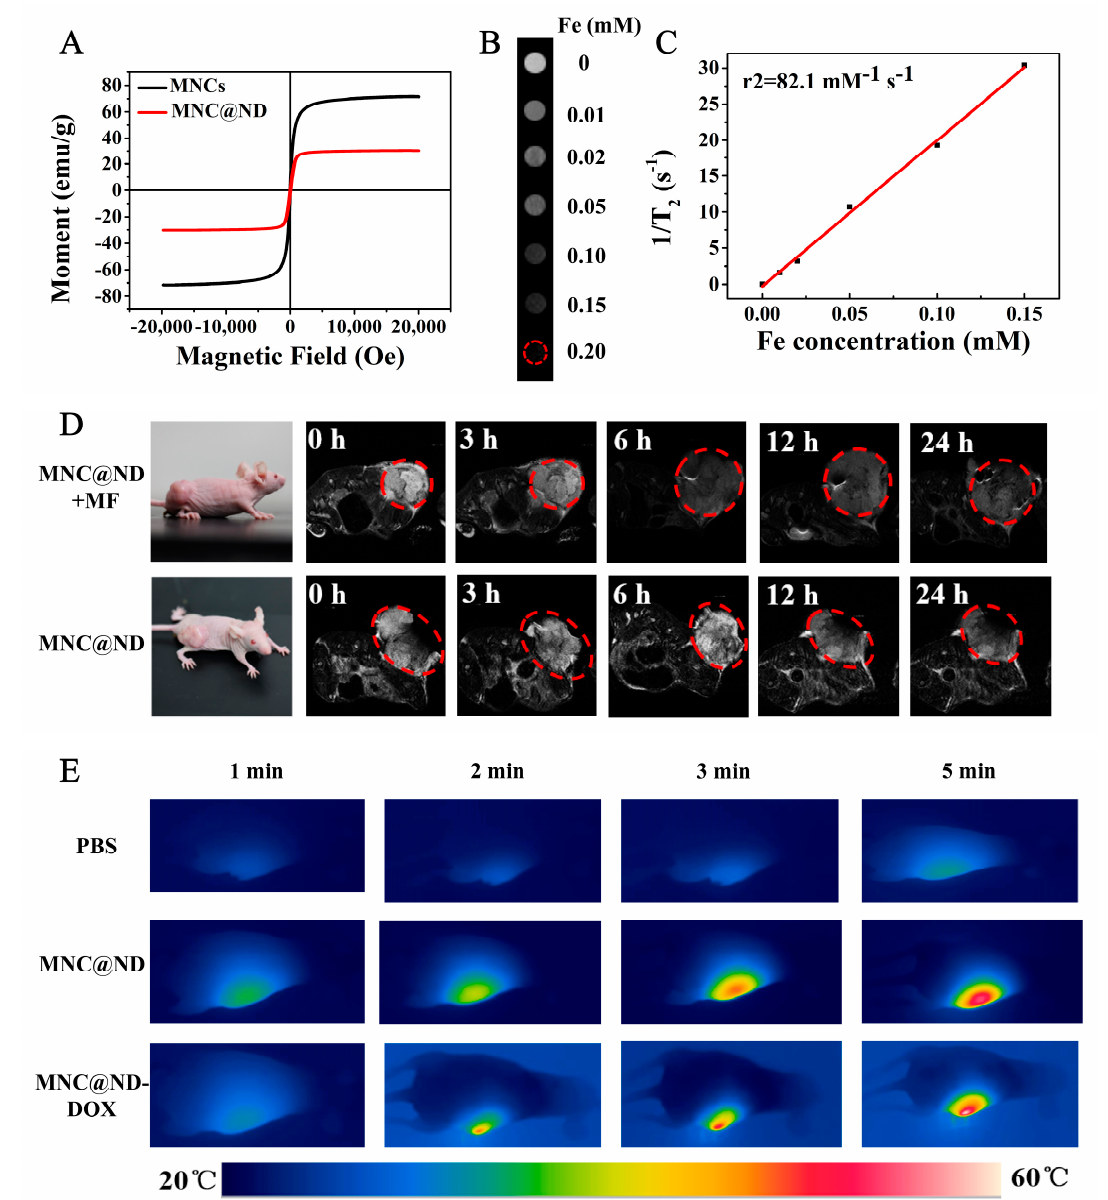
Figure 4. ( A ) Magnetization curve of MNCs and MNCs@ND. ( B ) T 2 − Weighted MR imaging of MNC@ND in PBS buffer (pH 6.0) incubated for different periods of time. ( C ) T 2 relaxation rates (r 2 ) in the case MNC@ND-DOX at different concentrations. ( D ) In vivo T 2 -weighted MR images of a tumor-bearing mouse taken before and after injection at 0, 3, 6, 12 and 24 h of MNC@ND-DOX (14.26 mg/kg). The tumor regions are pointed out in the red circle. ( E ) Infrared thermal images of tumor-bearing mice treated with PBS, MNC@ND, and MNC@ND-DOX via irradiation with 808 nm NIR light for different time